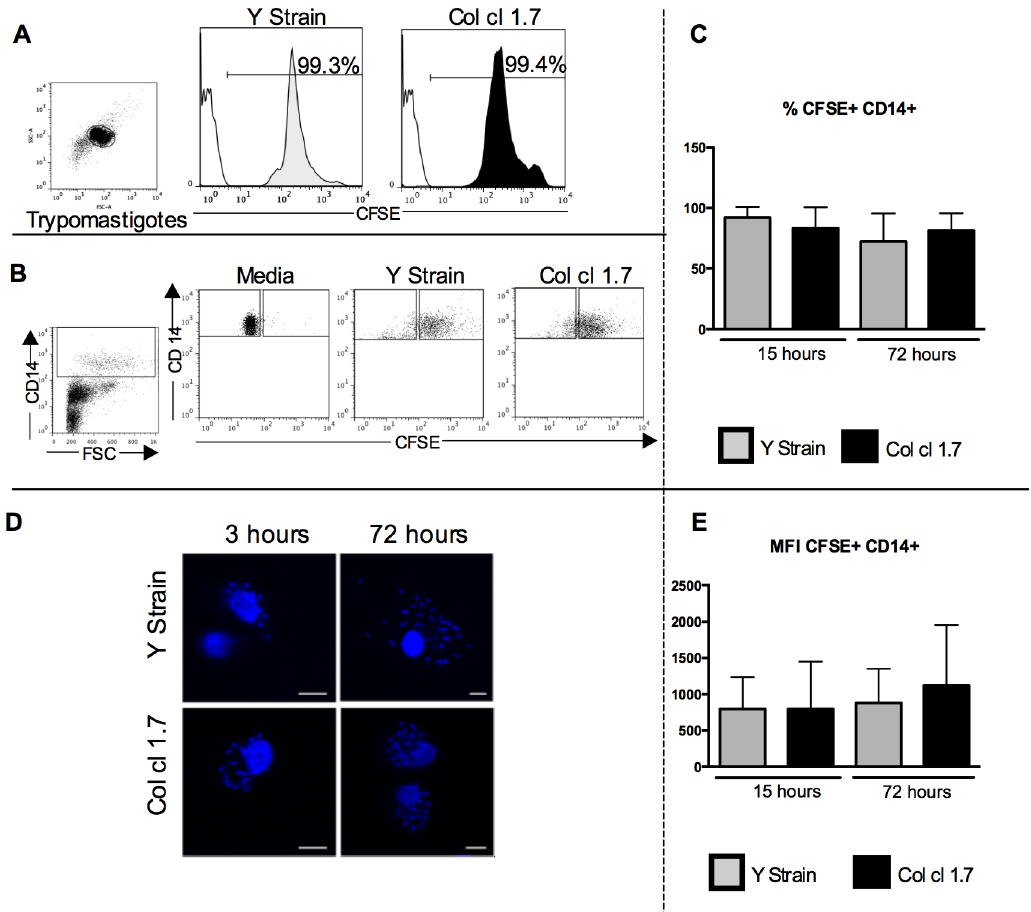
Fig 1. Evaluation of the frequency and intensity of T . cruzi infection in human monocytes. Results are expressed as average ± standard deviation. The symbol * indicates p < 0.05 between groups. Trypomastigotes from Y strain and Col cl1.7 were previously stained with CFSE and used for infections for 15 and 72 hours. (A) Representative figure of CFSE staining on trypomastigotes of Y strain and Col cl1.7. The plot shows the population of trypomastigotes; the white peaks in the histograms represent isotype control and the gray and black peaks represent Y and Col cl1.7 strains, respectively. (B) Representative figure of gating strategy for defining the CFSE+ and CFSE- in CD14+ cells, showing the first gate considering size (FSC) versus CD14 expression, followed by the gates considering CD14+ and CFSE+ and CFSE-. (C) Frequency of CFSE+ CD14+ cells. (D) Representative confocal microscopy analysis, showing DAPI-stained parasite ’ s nuclei inside monocytes. Cells were infected with Y strain or Col cl1.7 for 15 or 72 hours with 10 parasites/cell, preparation were stained with DAPI, and read on a confocal microscope, as described in material and methods; magnification x62. (E) Mean intensity of expression of CFSE